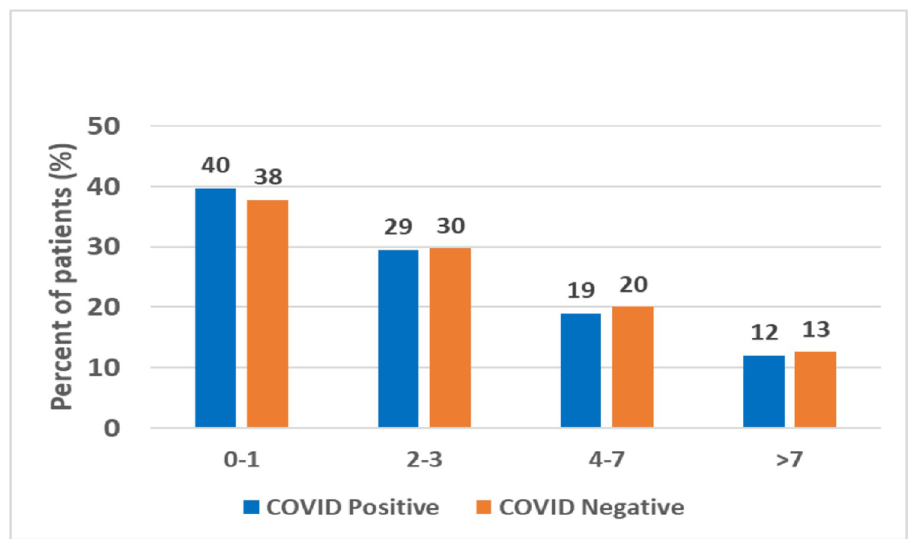
Fig 1. Days between onset of symptoms and specimen collection date.